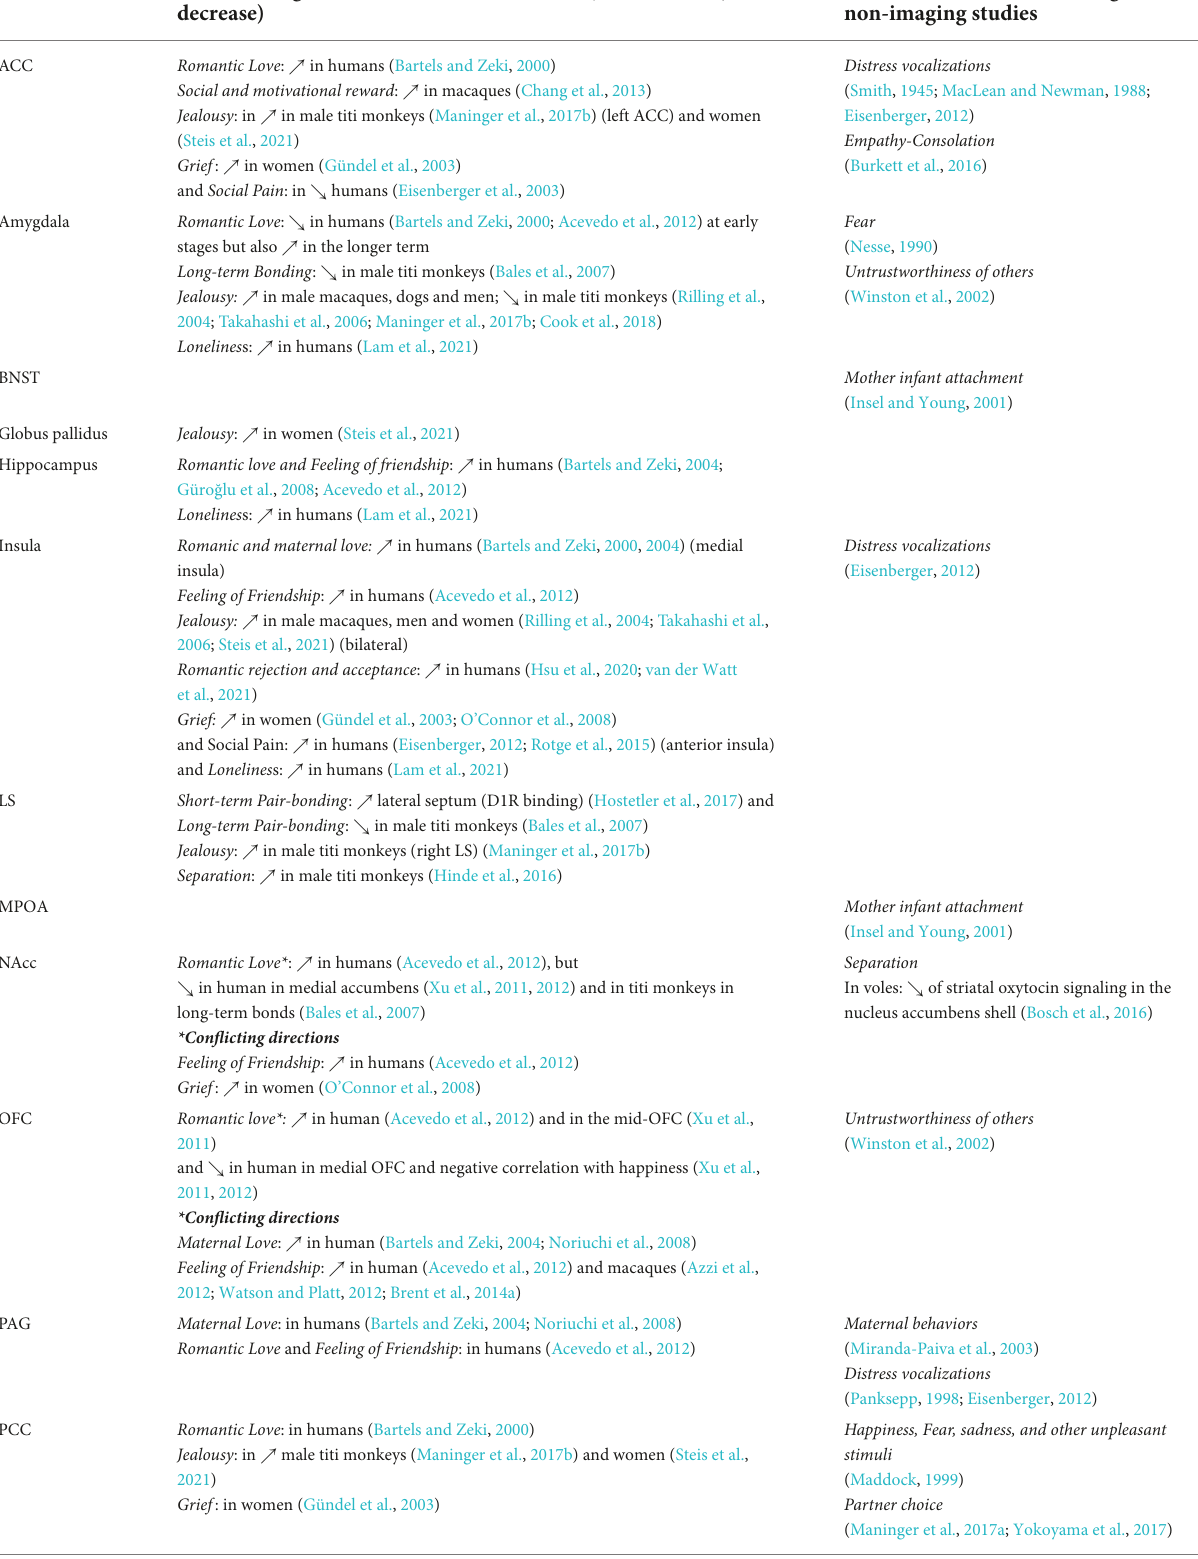
TABLE 6 Summary by brain areas of the regions most commonly involved in the expression the different social emotions across species. Brain